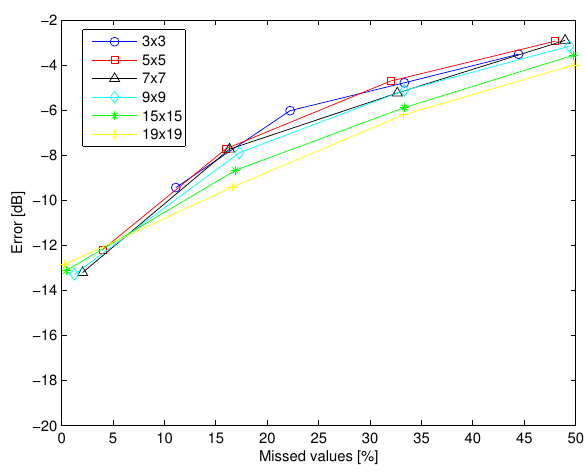
Figure 5. Error (dB) versus the percentage of missed data in case of 3 × 3, 5 × 5, 7 × 7, 9 × 9, 15 × 15 and 19 × 19 MIMO system, 10 scatterers and SNR equal to − 15 dB.